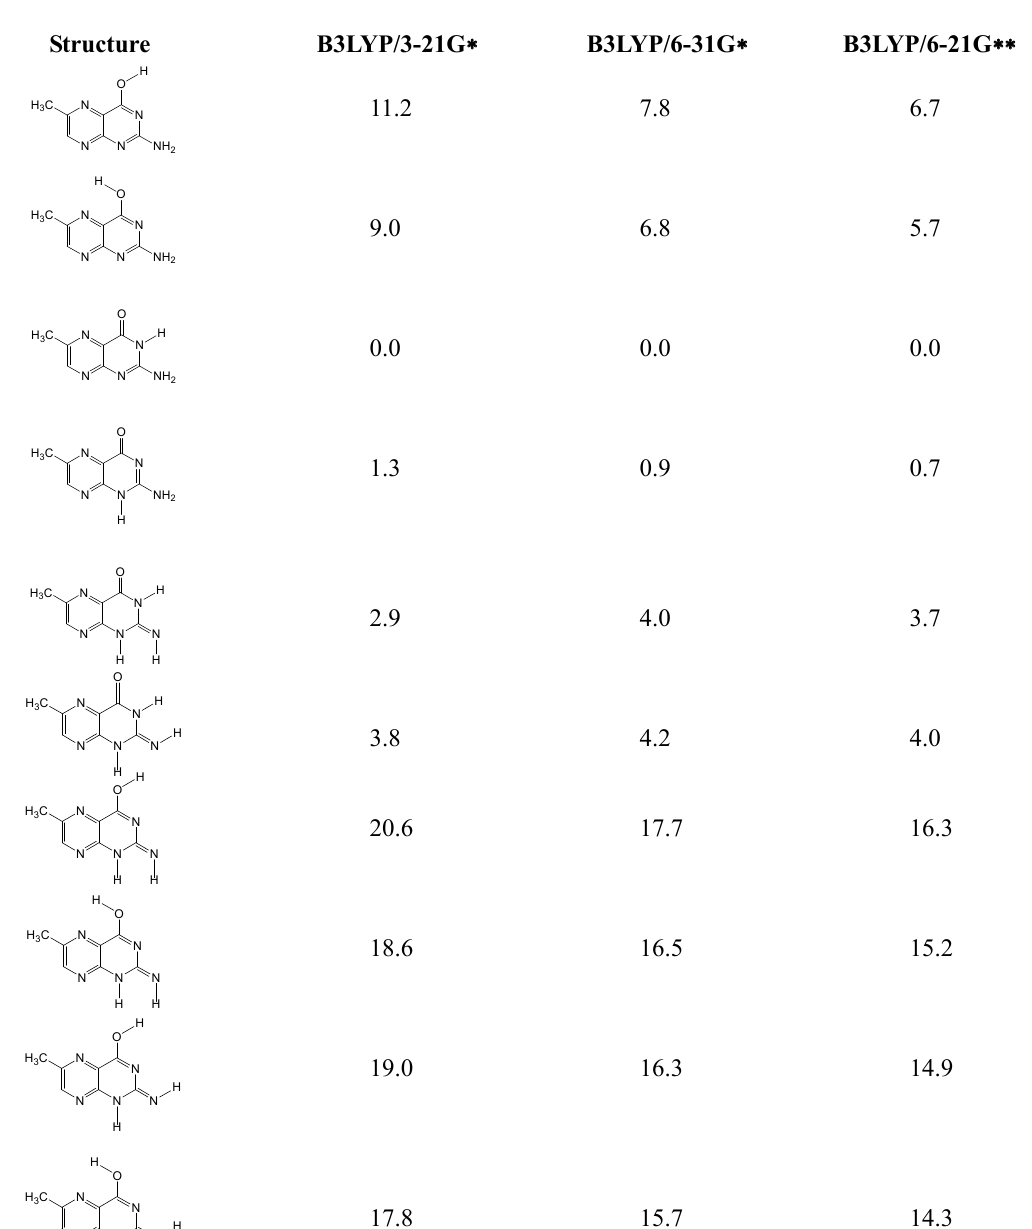
Table 1: Theoretical calculated ∆ G (kcal/mol) for neutral tautomers of pterins using B3LYP level of theory with 3-21G ∗ , 6-31G ∗ , and 6-31G ∗∗ basis